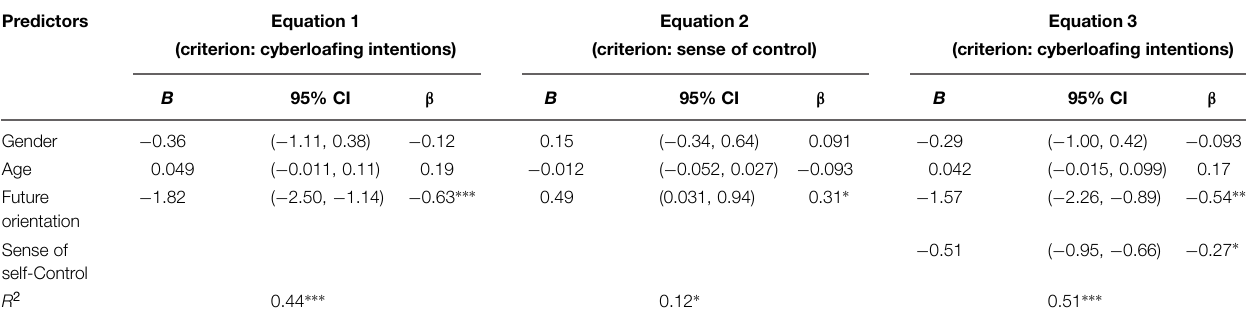
TABLE 4 | A test of the mediation effects of self-control on cyberloafing intentions ( N = 46). Predictors Equation 1 Equation 2